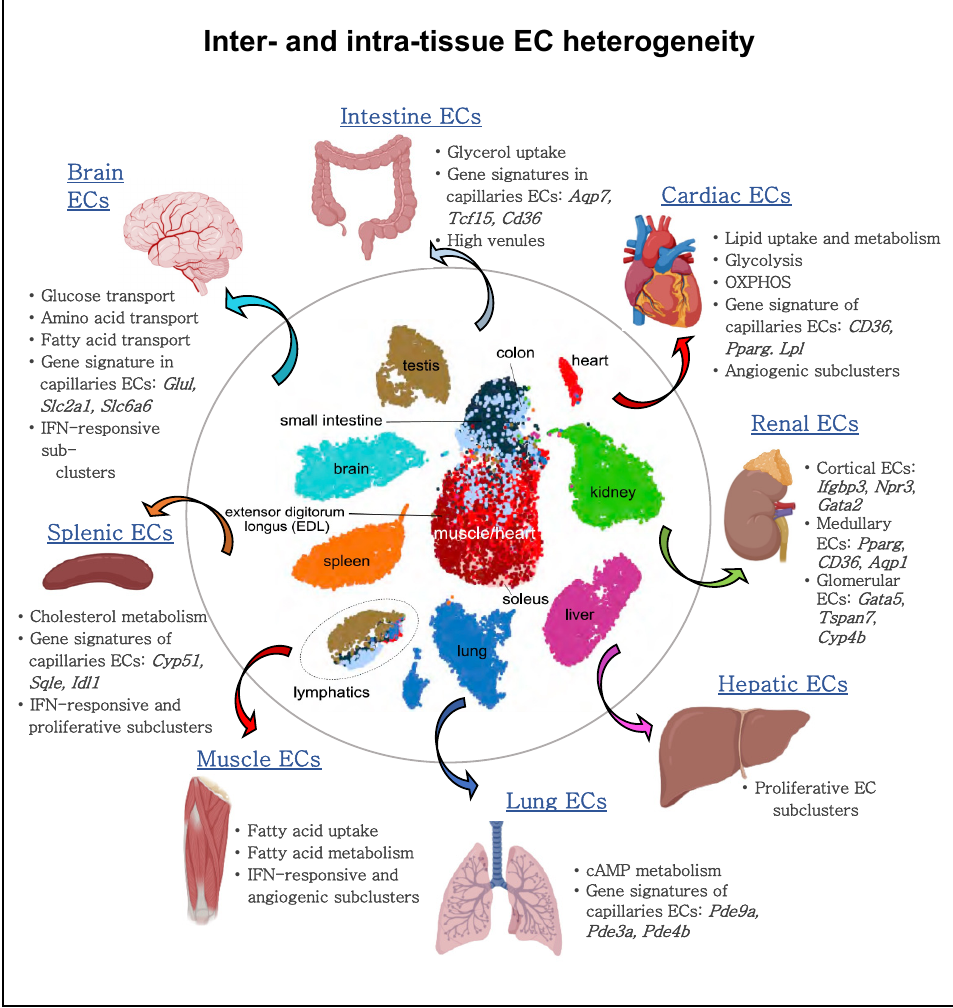
Figure 3. Inter- and intra-EC heterogeneity based on single-cell transcriptome profiles. Quiescent ECs isolated from different murine tissue types show heterogeneity between vascular beds and tissue-specific metabolic adaptations within the same organ. Quiescent cardiac and muscle ECs show an enriched gene signature implicated in lipid uptake and metabolism; lung ECs upregulate genes involved in cAMP metabolism; brain ECs upregulate the expression of glucose, amino acid and fatty acid transporters; splenic ECs increase the expression of cholesterol metabolism genes. Moreover, ECs from arteries, capillaries, and veins within the same organ display differential metabolic gene expression. For gene names, see the main text.